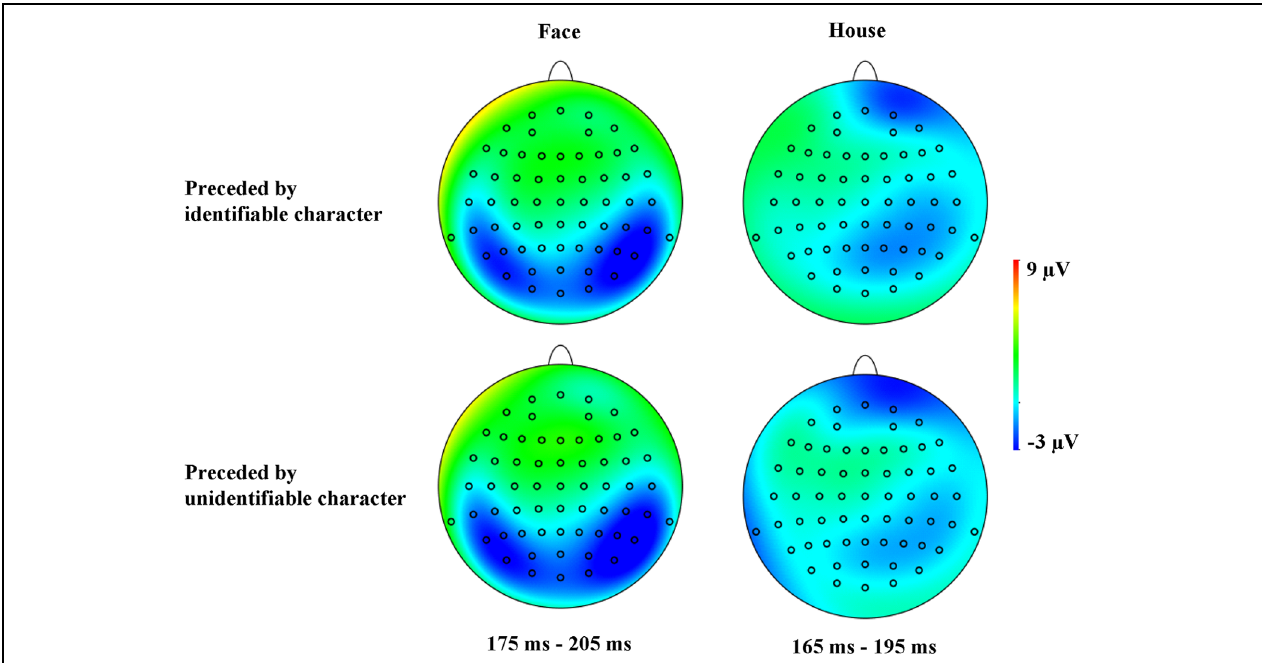
FIGURE 5 | Topographic maps for faces when they were simultaneously viewed with recognizable or unrecognizable character at 175–205 ms (Left) and for houses when they were simultaneously viewed with recognizable or unrecognizable character at 165–195 ms